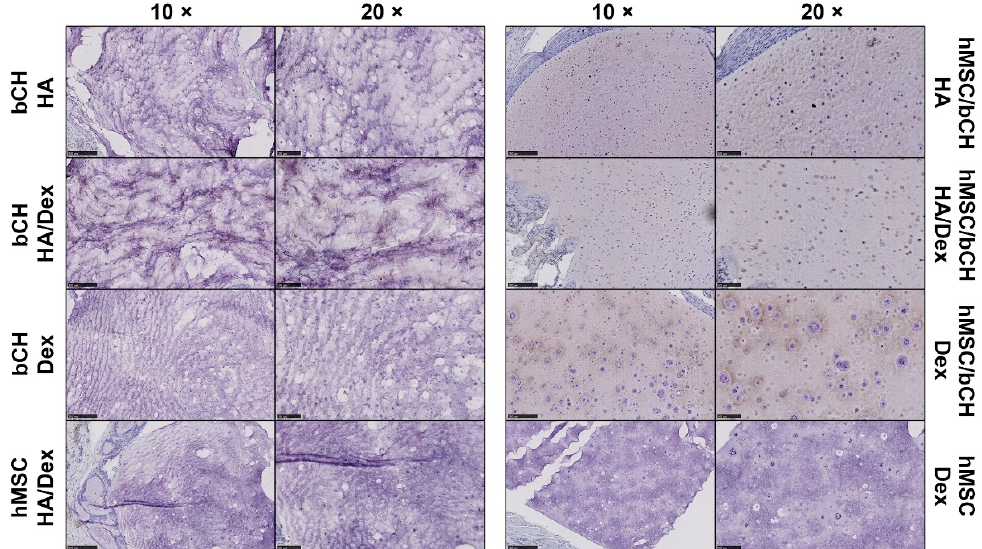
Figure 5. Matrix deposition after 28 days of subcutaneous implantation. Representative immunohistochemical staining of the hydrogel samples for COL II. Positive protein expression stained in dark brown. The left panel in each condition shows 10× magnification pictures (scale bars represent 250 μ m), whereas the right panel shows 20× (scale bars represent 100 μ m).